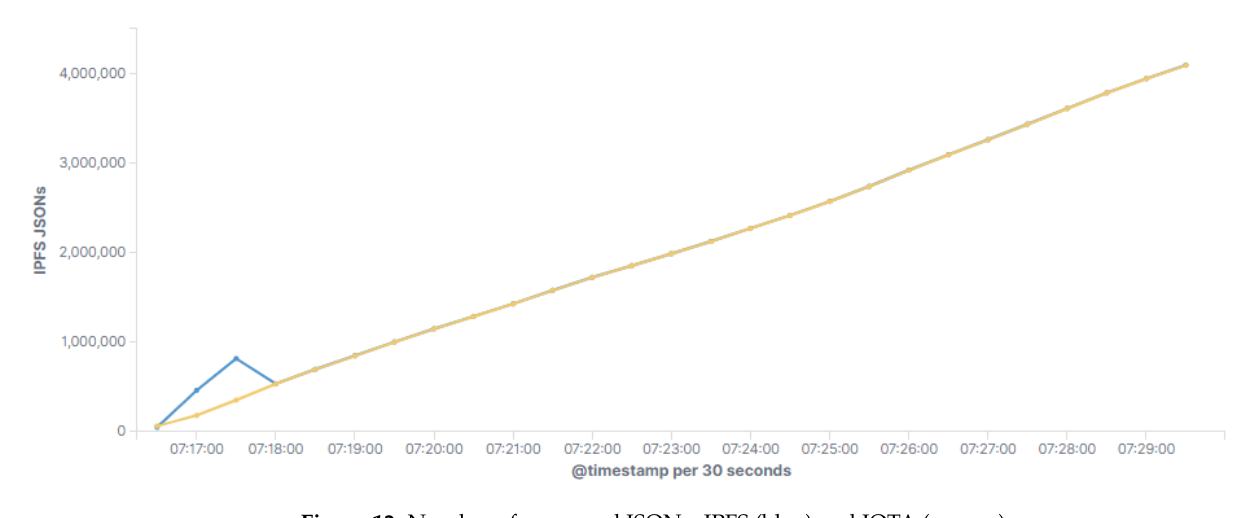
Figure 12. Number of processed JSONs: IPFS (blue) and IOTA (orange).